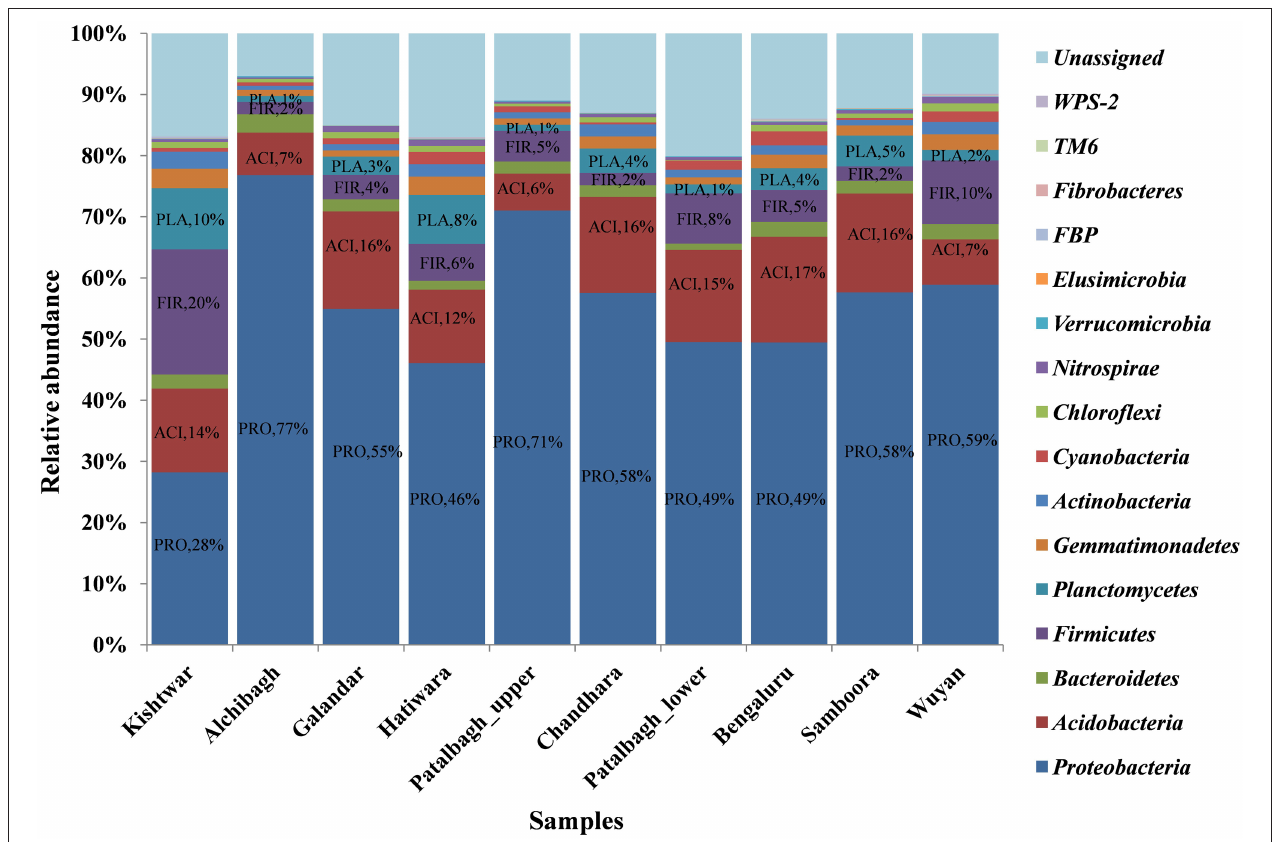
FIGURE 2 | Comparison of rhizo-bacteriome of saffron from different geographical location at phylum level representing dominance of Proteobacteria in all 10 samples. The relative abundance of Proteobacteia is less in Kishtwar (Jammu) as compared to all the samples from Kashmir and Bengaluru whereas Firmicutes and Planctomyces are more in Kishtwar as compared to others. PRO, Proteobacteria ; FIR, Firmicutes ; ACI, Acidobacteria ; PLA, Planctomycetes